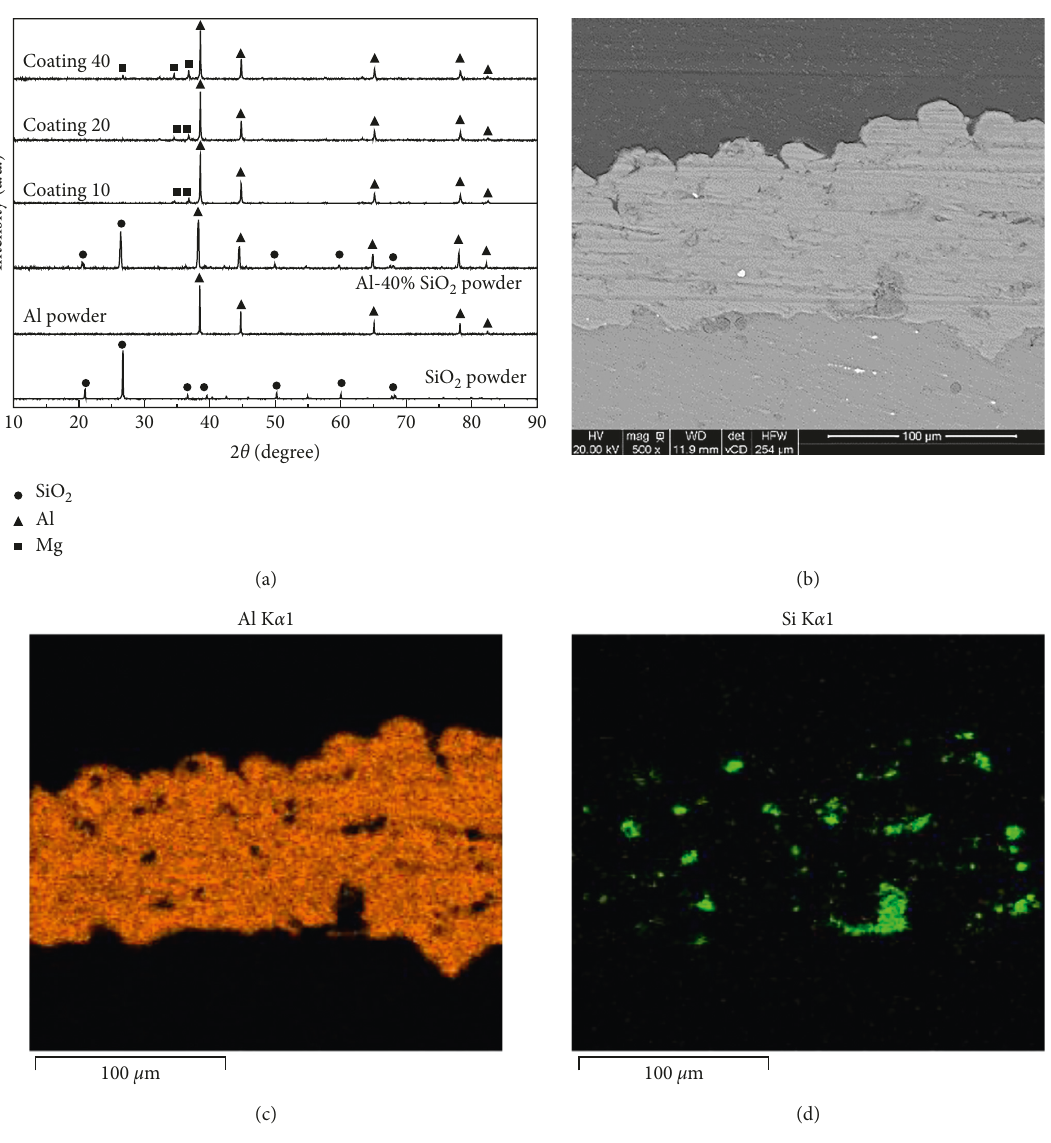
Figure 2: XRD spectra of the powders and the coatings (a) and the typical EDS mapping analysis of the composite coating named as coating 40